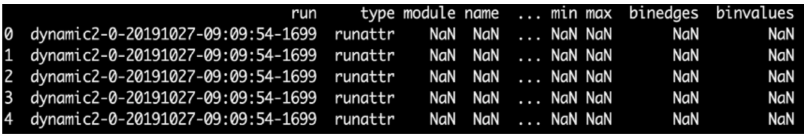
Figure 13. Conversion of network packet files to the CSV format.